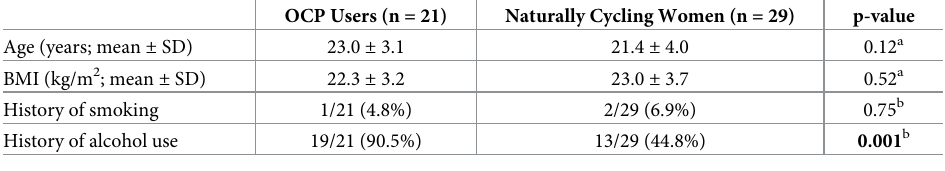
Table 1. Demographic features of the